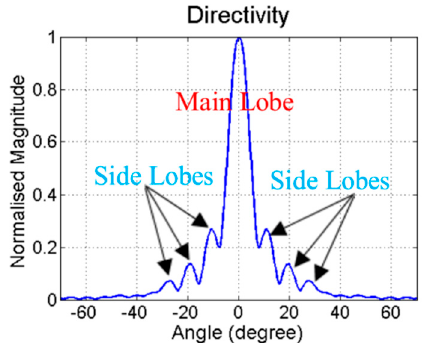
Figure 14. The simulated beam directivity of Rayleigh waves at z = 0. Reproduced with permission from [15], IEEE, 2016.